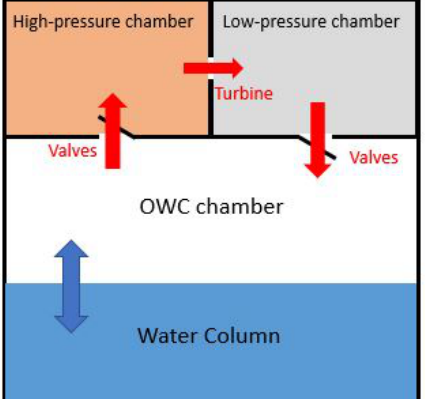
Figure 1. Schematic diagram of the Tupperwave device